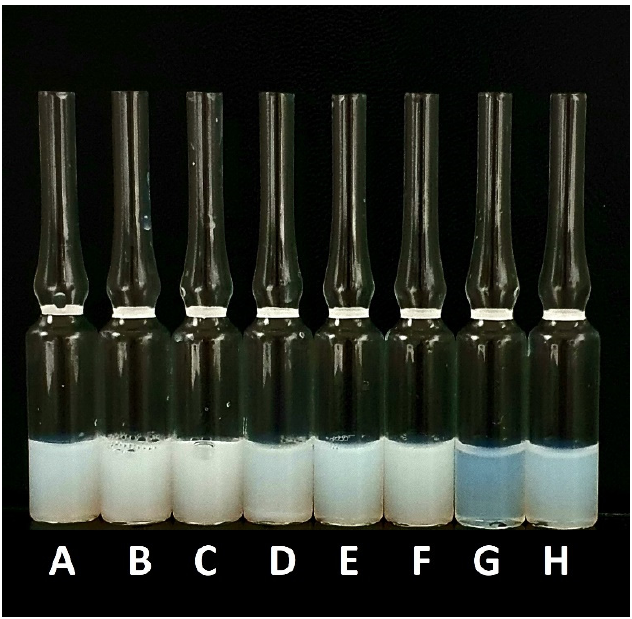
Figure 3. Visual appearance of the obtained nanoparticles: ( A ) PLGA, ( B ) UA-PLGA, ( C ) S100-PLGA, ( D ) UA-S100-PLGA, ( E ) S95-PLGA-PEG 2000, ( F ) UA-S95-PLGA-PEG 2000, ( G ) S85-PLGA-PEG 2000, and ( H ) UA-S85-PLGA-PEG 2000.